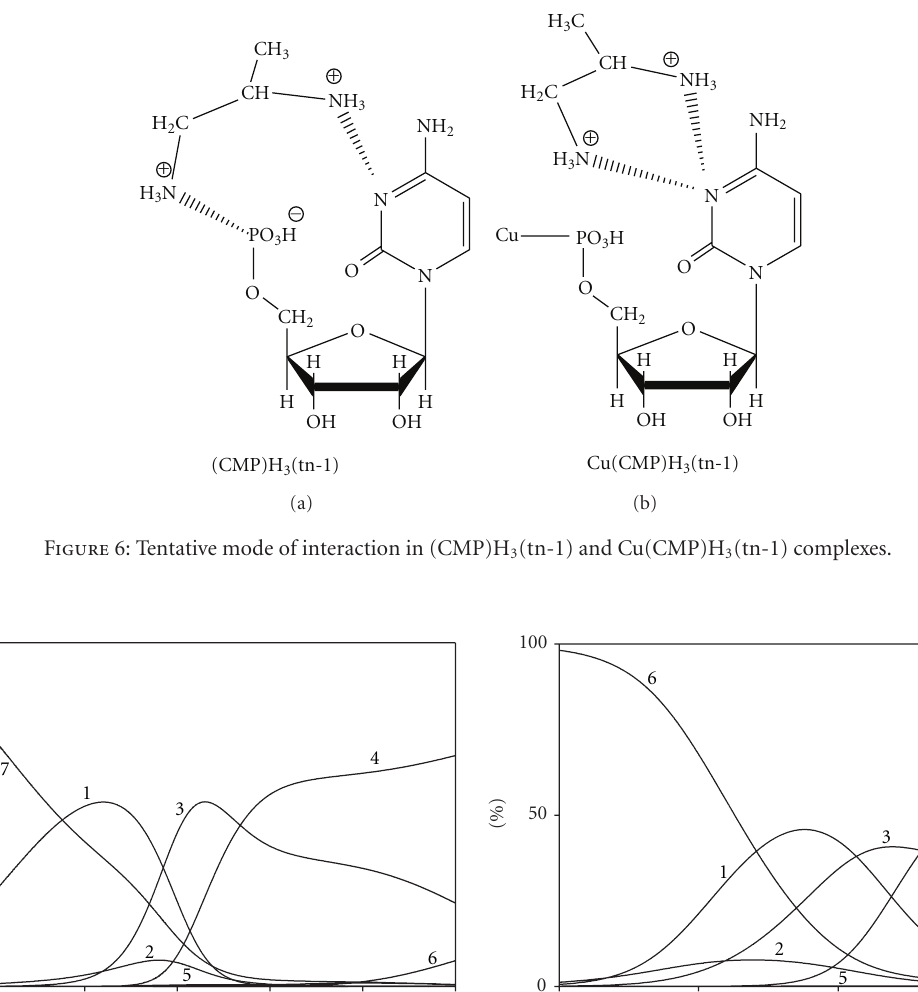
both amine groups are protonated and act as the positive centres in the noncovalent interactions leading to formation of the ML ··· L adduct. As follows from the changes in the chemical shifts of C 1 , C 2 , and C 3 of the amine equal to 0.000, group at C 2 is involved 0.094, and 0.046 ppm, only the –NH + 3 in the noncovalent interactions. The presence of the metal ions induces changes in the mode of interaction relative to that in the metal-free system of AMP/tn-2. The coordination of Cu(II) by the phosphate groups prevents the formation of and the protonated noncovalent interactions between-PO − 3 amine groups of tn-2, as schematically presented in Figure 8. This molecular-level e ff ect should be considered during analyses of the interactions between polyamines and nucleic acids because the interaction can influence the characteristics of gene